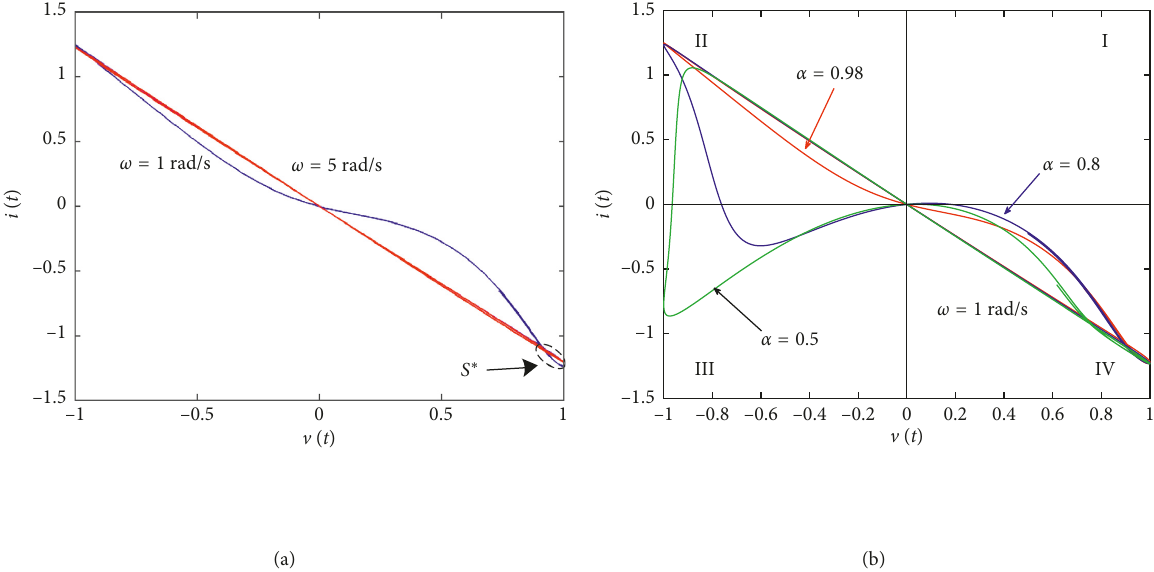
Figure 2: v ( t ) versus i ( t ) of the fractional-order memristor. (a) The order α � 0.98 with two different frequencies; (b) the frequency ω � 1rad/s with three different fractional